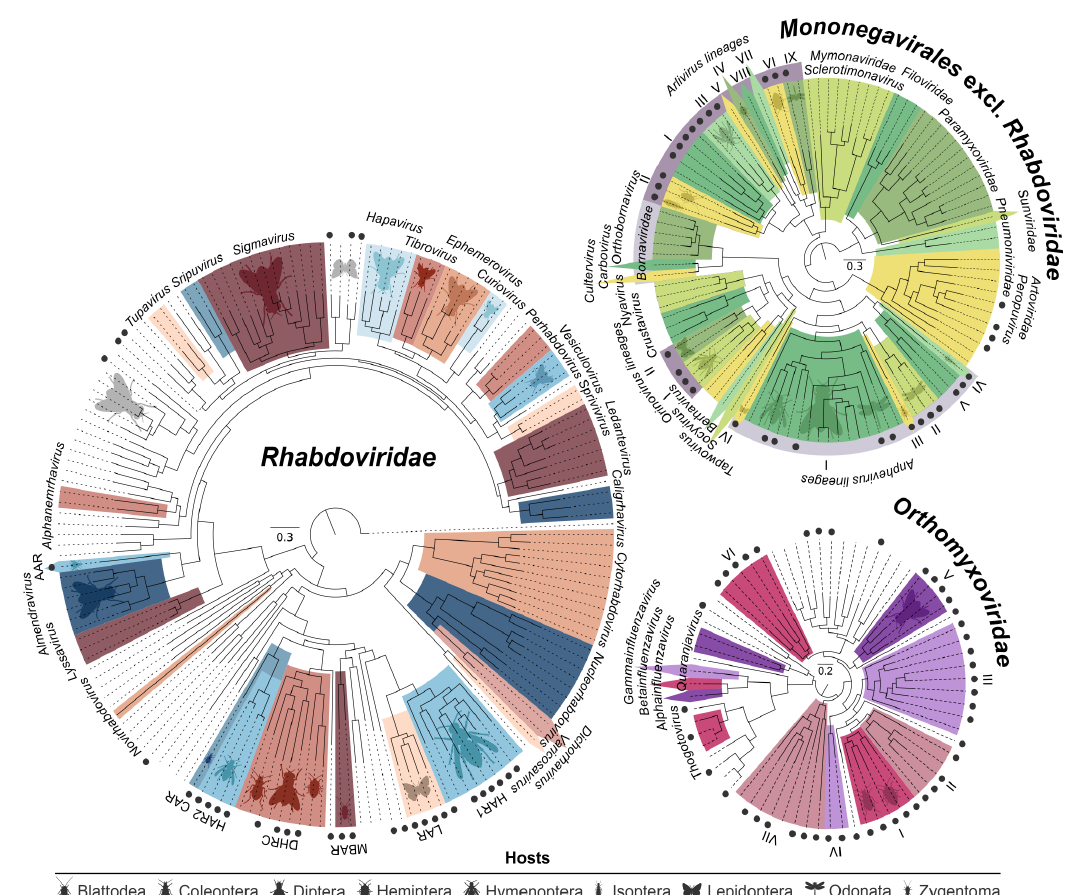
Figure 6. Maximum-likelihood phylogenies of viruses found in our study [54], classified viruses by ICTV, as well as selected unclassified viruses. Novel viruses from our study are identified by black circles. Abbreviations for the Rhabdoviridae phylogeny are: AAR—Almendra-related virus, CAR—Coleoptera-related viruses, HAR1 and − 2—Hymenoptera-related viruses, DHRC—Diptera-, Hymenoptera-, and Coleoptera-related viruses, LAR—Lepidoptera-related viruses, MBAR—Mantodea-, and Blattodea-related viruses. The Orthomyxoviridae and the Mononegavirales excl. Rhabdoviridae phylogenies carry annotations in roman numbers for the different Orthomyxoviridae lineages, and Arlivirus , Orinovirus , and Anphevirus lineages that are defined after the addition of our data. Insect host orders relative to clades are watermarked wherever